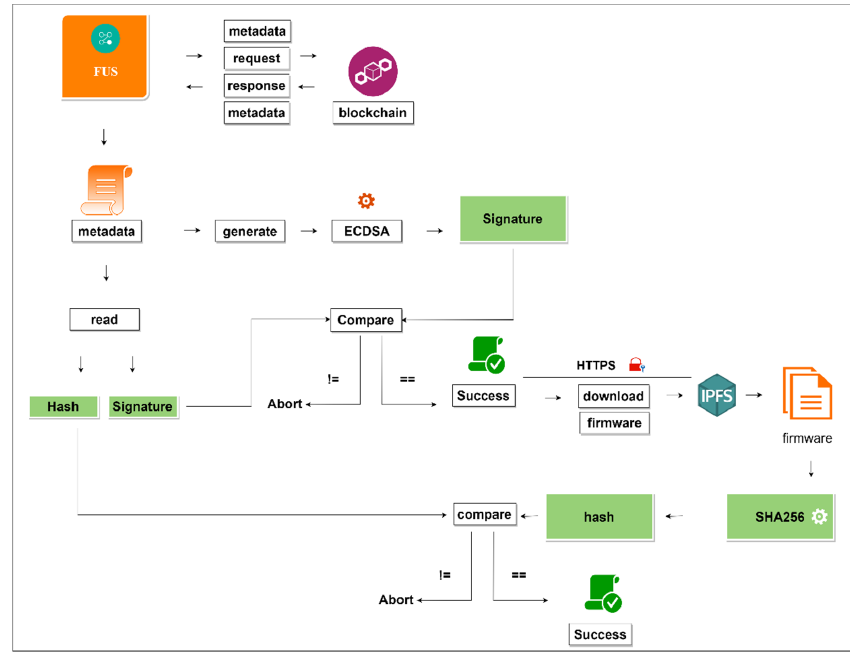
Figure 8. Firmware Downloads and Verification Phase.